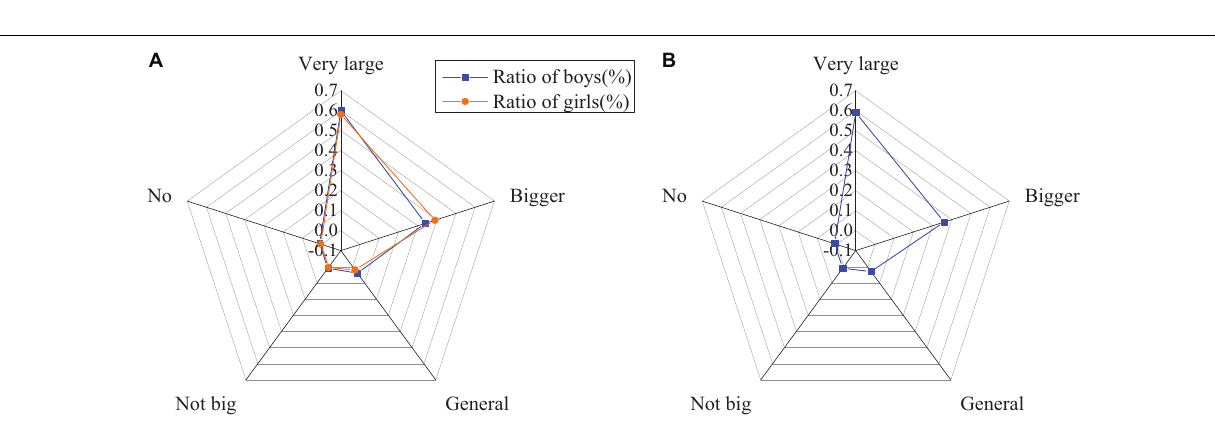
FIGURE 10 | Influence of network information on the psychology of college students [ (A) the ratio of males and females; (B) the ratio of all].